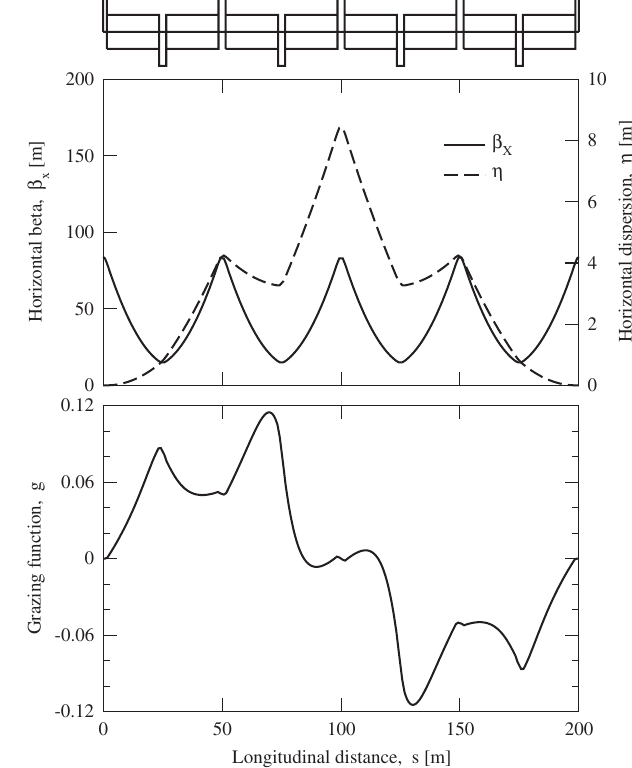
FIG. 2. The matched periodic grazing function g FODO cells, with a bend angle of (cid:8) ¼ (cid:5)= 50 per half cell of length L ¼ 25 m , and a total phase advance of 360 degrees in both planes. The grazing function is dominated by the 4 (cid:4) harmonic, with a maximum value of 0.0268 that is in good agreement with the thin quadrupole prediction of